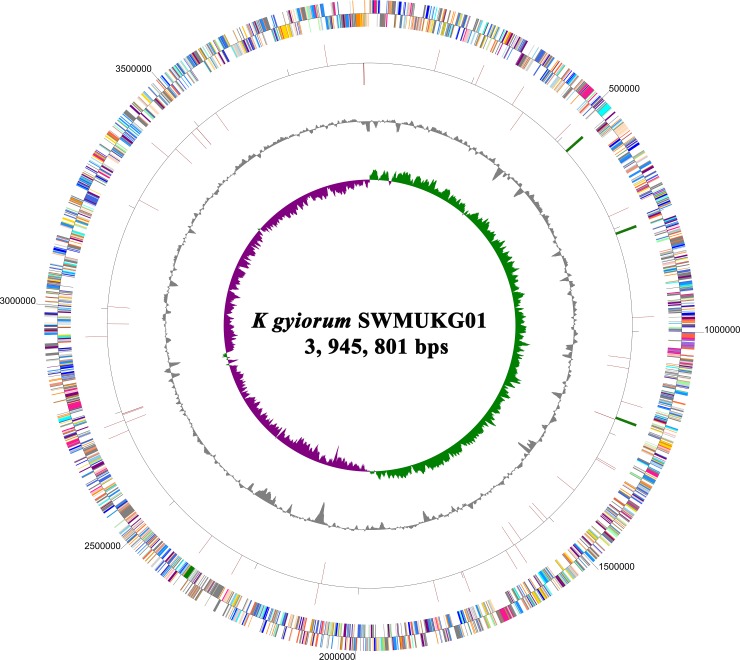
Circular map of the complete genome of K. gyiorum SWMUKG01.Circles from outside to inside: CDS on the forward strand (1) and CDS on the reverse strand (2), belonging to different COG categories were indicated by different colors; rRNA and tRNA genes (3); GC content (4); GC skew with + value (green) and–value (purple) (5).